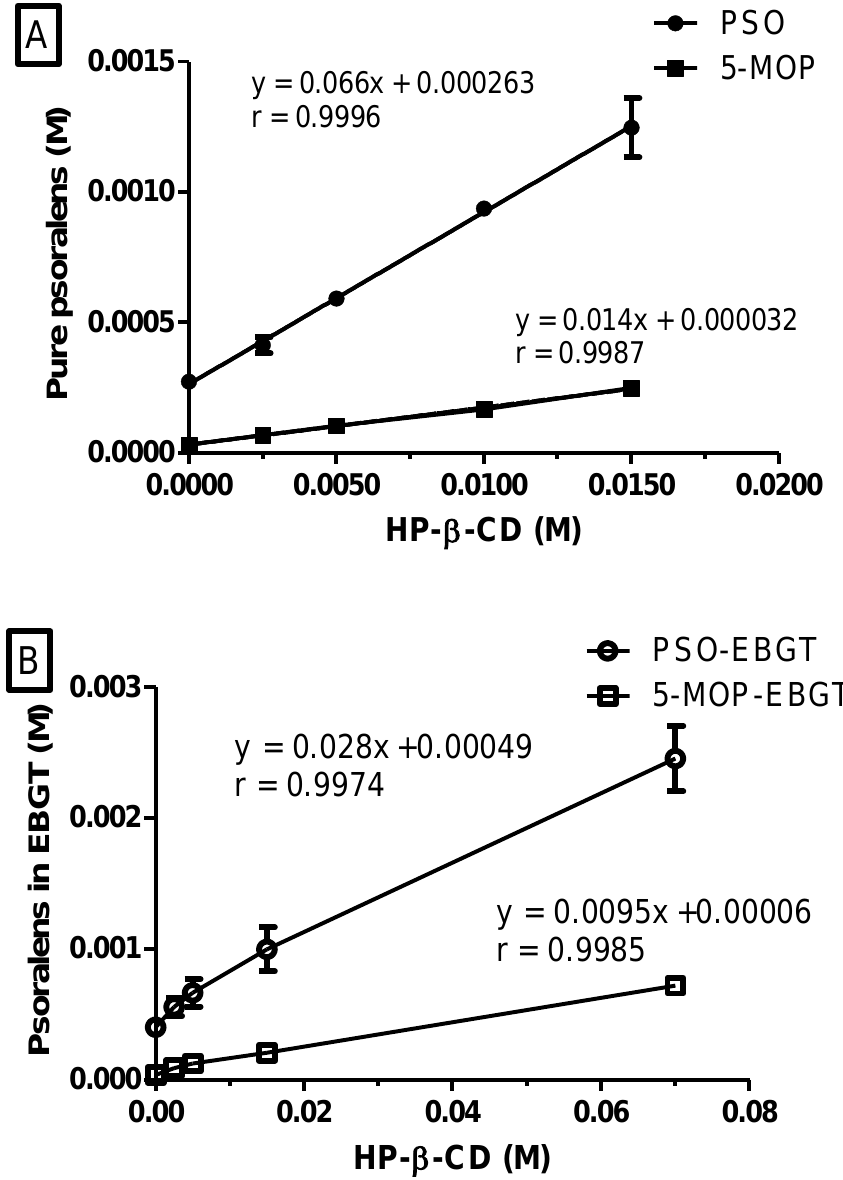
Figure 1. Solubility of psoralens standards ( A ) and psoralens in EBGT ( B ) as a function of HP- β -CD concentration in KRB buffer solutions (pH 7.4; 37 °C). Data shown as mean ± SD (error bars smaller than symbols); n = 3.